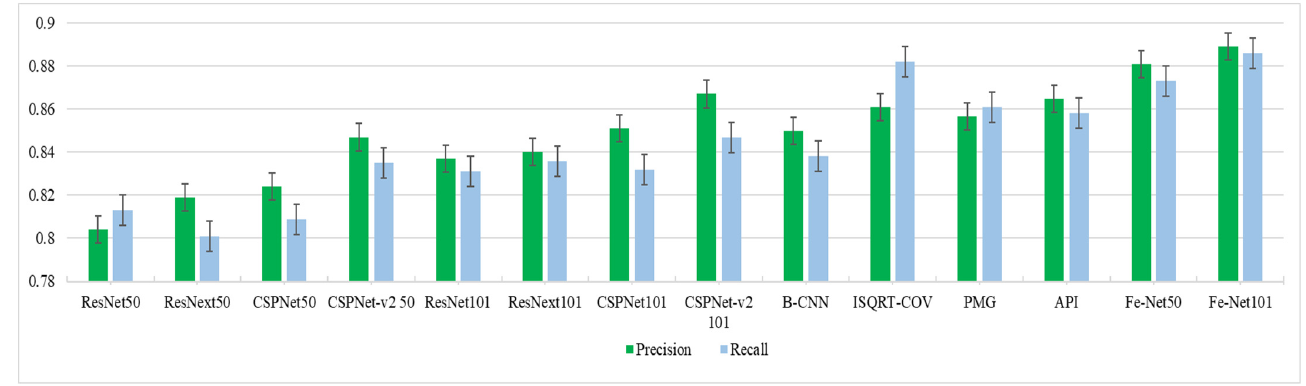
Figure 8. Precision and recall results of different models.